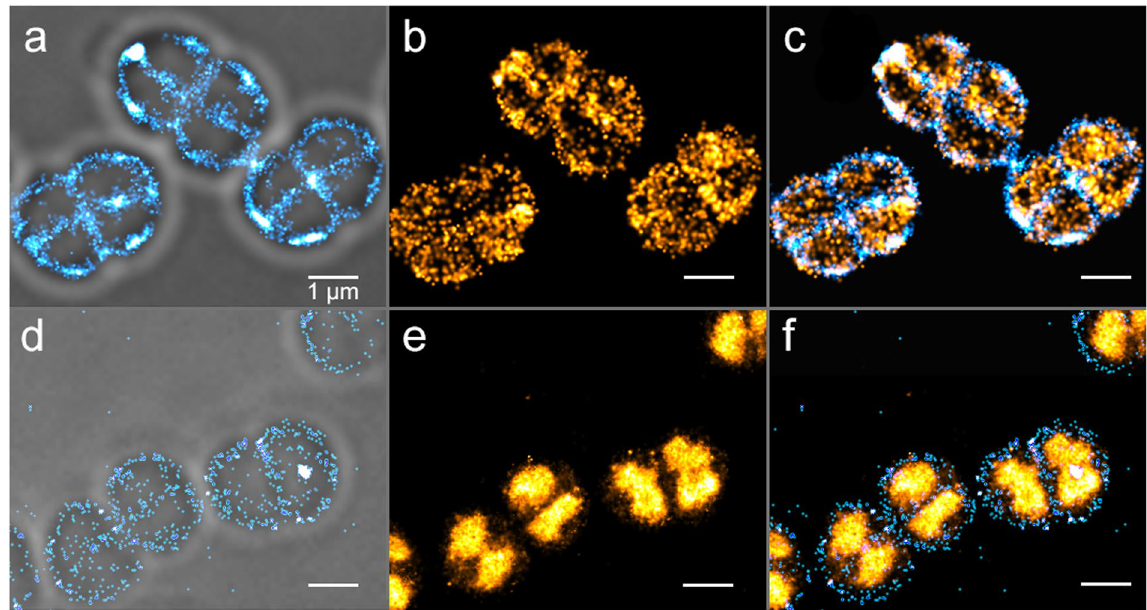
Figure 7. Two-color PALM/PAINT imaging of D. radiodurans . ( a – c ) PALM/PAINT imaging of D. radiodurans cells expressing cytoplasmic PAmCherry. ( a ) Autoblinking-based PAINT image (50 ms frametime; 561 nm laser only), superimposed on the brightfield image. ( b ) PAmCherry-based PALM image (4.8 ms frametime; 561 nm plus 405 nm lasers). (c ) Superimposed image of ( a ) and ( b ). ( d – f ) PALM/PAINT imaging of D. radiodurans cells expressing PAmCherry fused to HU. ( d ) Autoblinking-based PAINT image (50 ms frametime; 643 nm laser), superimposed on the brightfield image. ( e ) PAmCherry-based PALM image (50 ms frametime; 561 nm laser). ( f ) Superimposed image of ( d ) and ( e ). Scale bar: 1 μ